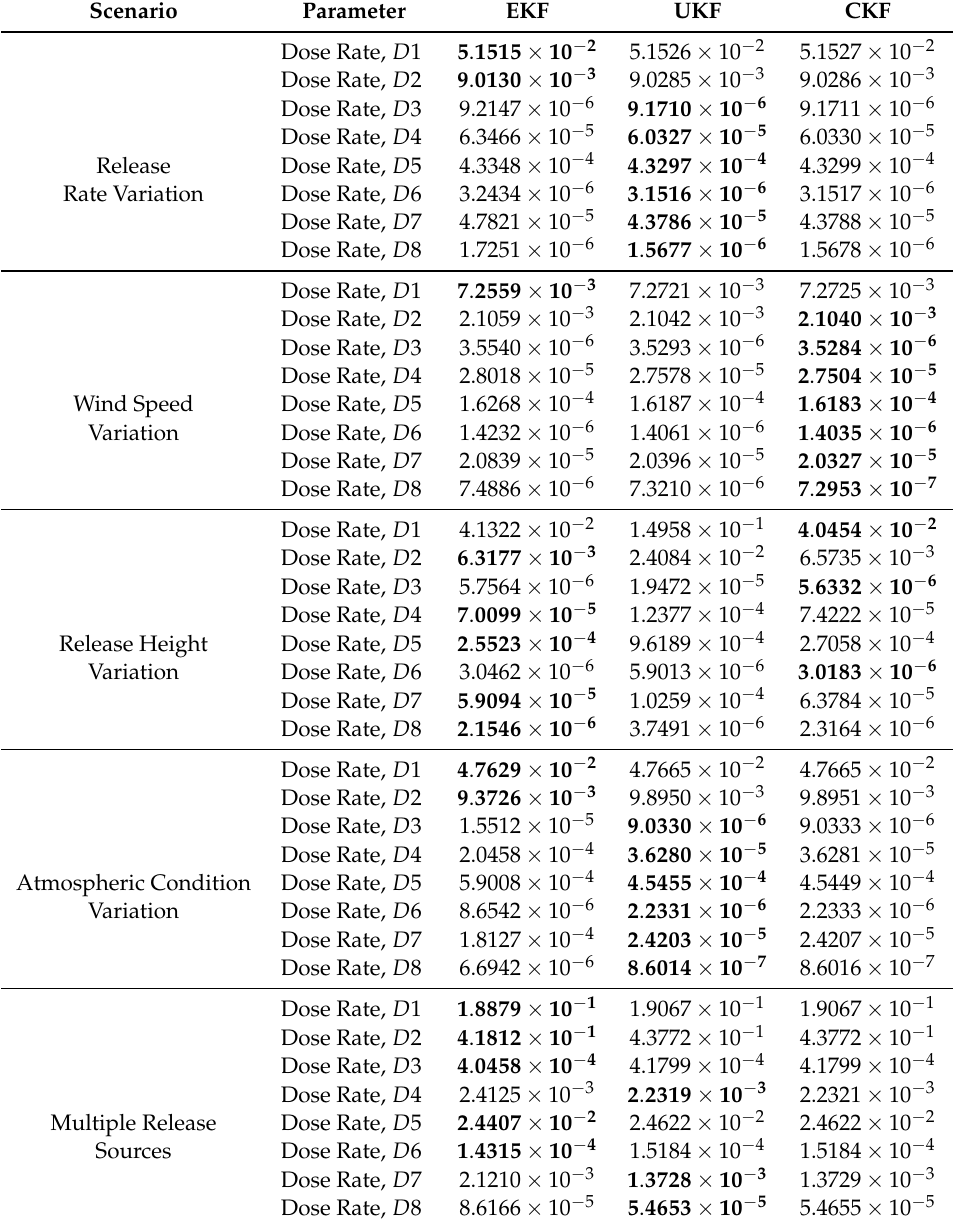
Table 1. Root mean squared error between true and estimated dose rates for EKF, UKF, and